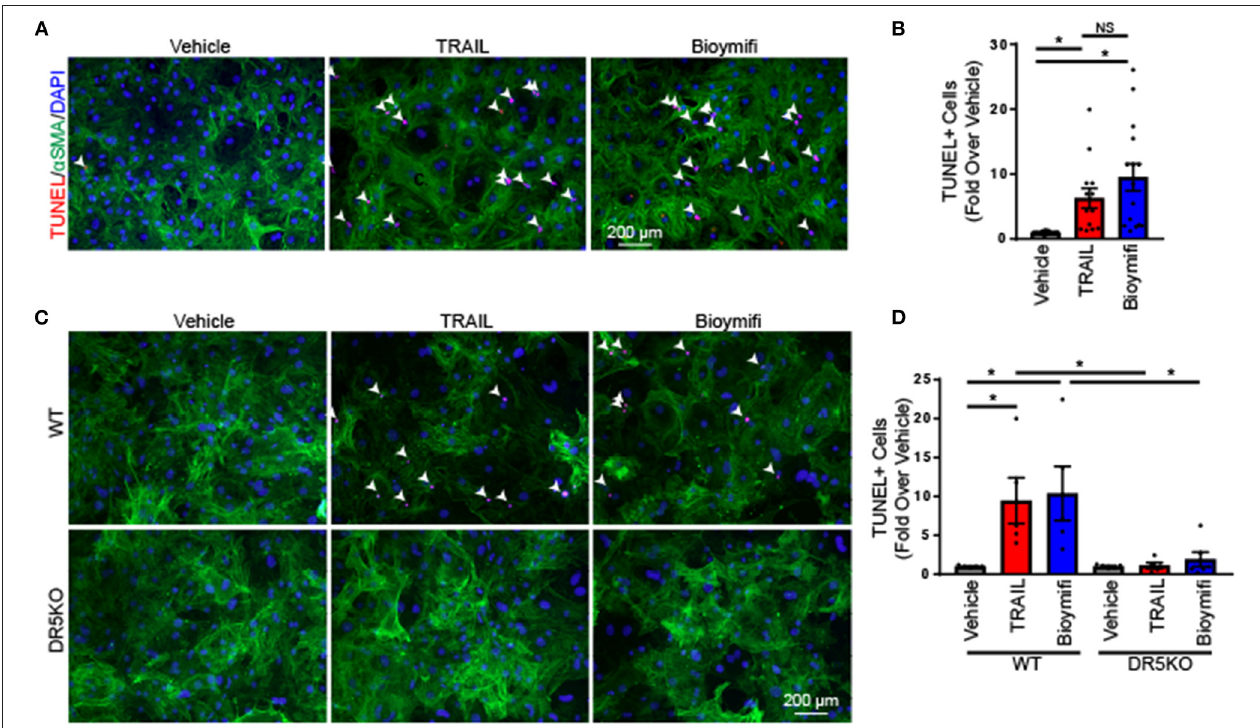
FIGURE 3 | DR5 activation induced death in myofibroblasts. (A) Apoptosis was examined by TUNEL staining (red) in rat neonatal myofibroblasts treated with vehicle, TRAIL, or bioymifi. α SMA staining (green) was used to label myofibroblasts and DAPI staining (blue) shows nuclei. (B) Quantification of the number of TUNEL-positive nuclei in myofibroblasts treated with TRAIL, bioymifi, or vehicle control. n = 8. One-Way ANOVA, * p < 0.05. Representative (C) and quantified (D) TUNEL staining for myofibroblasts from adult WT and DR5KO mouse hearts treated with TRAIL or bioymifi. α SMA staining (green) was used to label myofibroblasts and DAPI staining (blue) shows nuclei. Data presented as fold over vehicle from the same mouse. n = 5, Two-Way ANOVA, * p < 0.05.